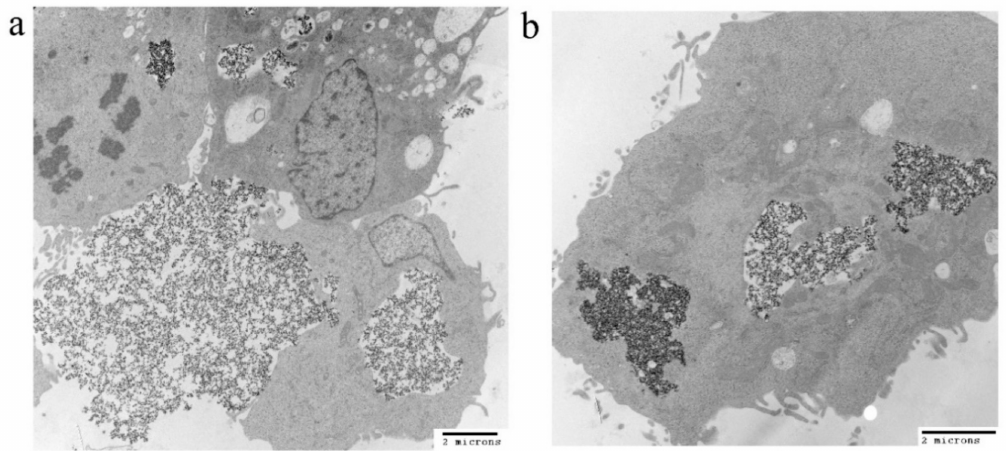
Figure 4. TEM images of ( a ) IONP and ( b ) Sali-IONP uptake by U251 cells after 4 h of the treatment.